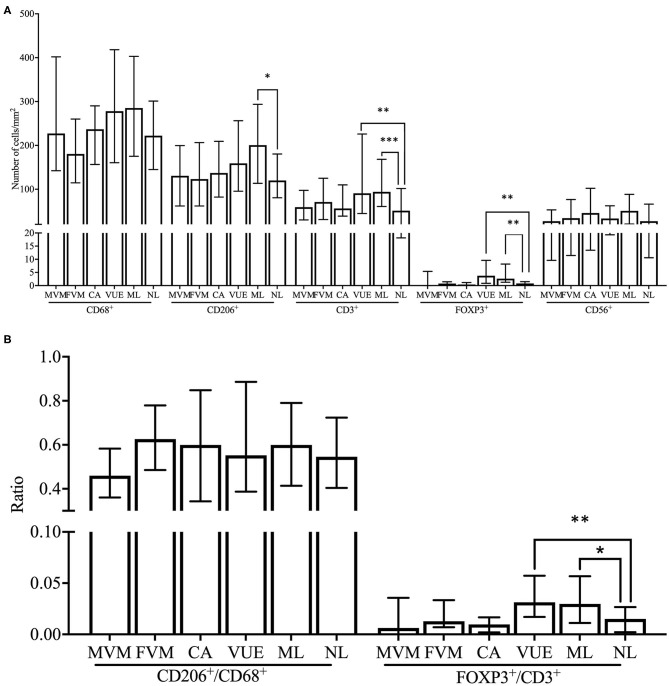
Comparison of immune cell subsets and ratios between placental lesions within the FGR cohort. (A) Numbers of cells/mm2 are shown for CD68+ macrophages, CD206+ M2 macrophages, CD3+ T cells, FOXP3+ Treg cells, and CD56+ NK cells and compared between placental lesions [MVM (n = 18), FVM (n = 17), CA (n = 27), VUE (n = 45), ML (n = 44), and NL (n = 44)] within the FGR cohort with the Kruskal Wallis test and pairwise Dunn's non-parametric comparison test as post-hoc test. Data presented as median + IQR. *p < 0.05, **p < 0.01, ***p < 0.001. (B) Ratios of number of cells/mm2 are shown for CD206+/CD68+ macrophages and FOXP3+/CD3+ T cells and compared between placental lesions within the FGR cohort with the Kruskal Wallis test and pairwise Dunn's non-parametric comparison test as post-hoc test. Data presented as median + IQR. *p < 0.05, **p < 0.01. MVM, maternal vascular malperfusion; FVM, fetal vascular malperfusion; CA, chorioamnionitis; VUE, villitis of unknown etiology; ML, multiple lesions; NL, no lesions.